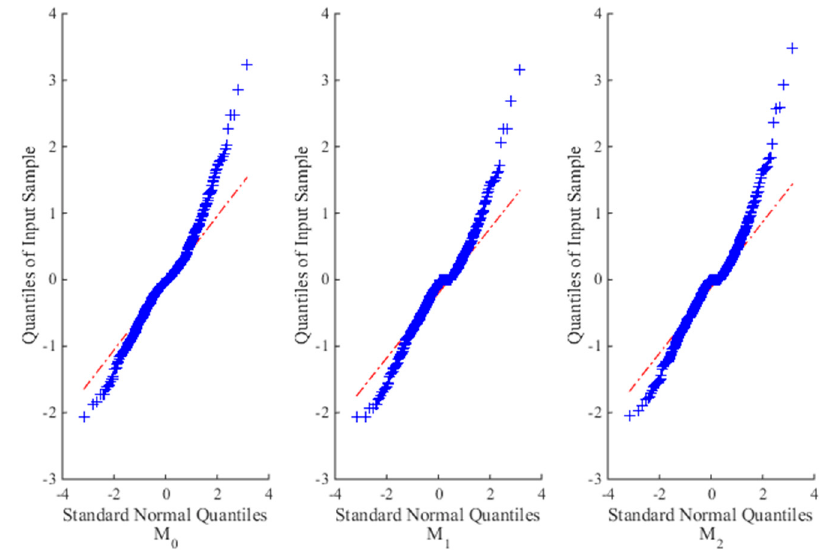
Figure 9. The Q-Q plots for three candidate models for the resistor data. Table 5. Resistor application: parameter estimates for three candidate models with random drift coefficients ( b ≠ 0).